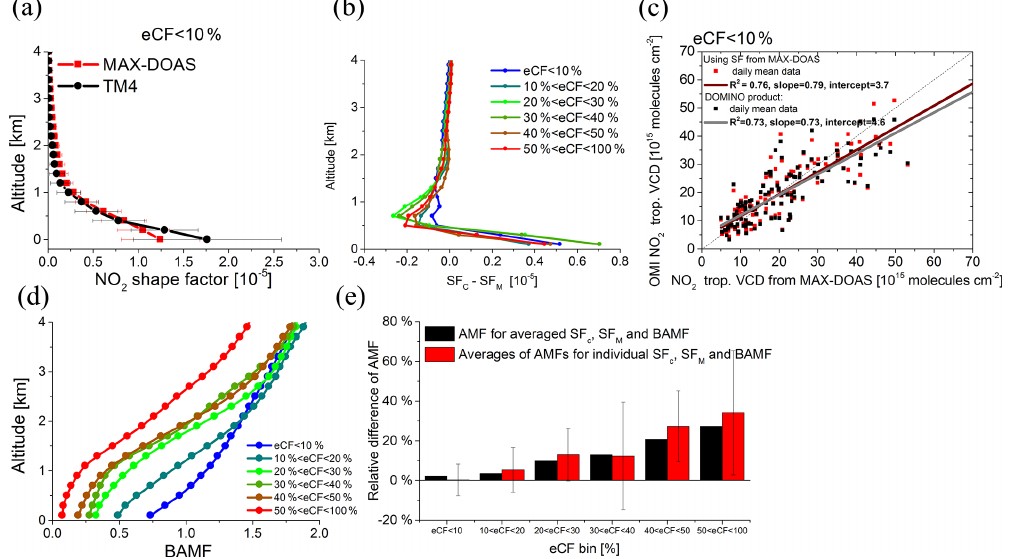
Figure 9. (a) Average NO 2 SFs and standard deviations derived from the MAX-DOAS observations and from the TM4 CTM (for the DOMINO product) for eCF<10%. (b) Averaged differences between the NO 2 SFs from CTM (SF C ) and from MAX-DOAS (SF M ) for different eCF bins. (c) Daily averages of the original DOMINO NO 2 product and modified NO 2 product (based on MAX-DOAS SF) plotted against those from MAX-DOAS for eCF<10%. (d) Averaged BAMF for satellite observation for different eCF bins. (e) Relative difference (RD) of satellite AMF using SF C (AMF CTM ) or SF M (AMF MAX − DOAS ) for different eCF bins. The error bars indicate the standard deviation of the RDs for each eCF bin. Black columns denote the RDs derived from the averaged SF C , SF M and BAMF (shown in b and d ); red columns denote the averaged RDs for individual SF C , SF M and BAMF of each satellite